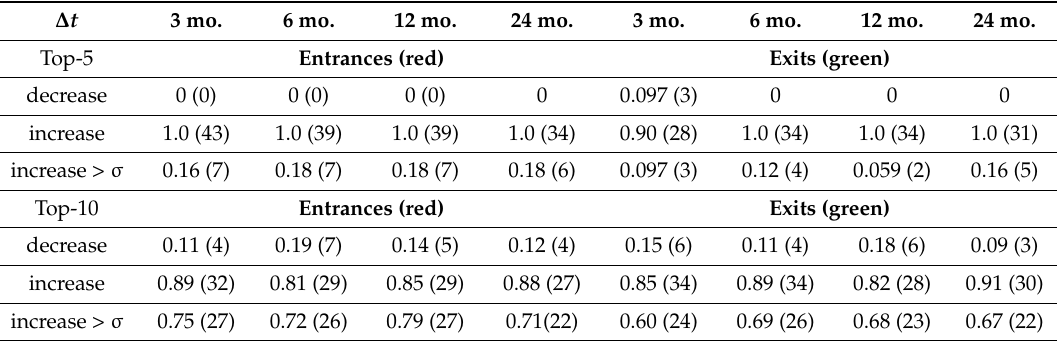
Table 3. Rates (and the counted numbers in the brackets) of the in/decrease of stock prices at (i.e., from the period of length ∆ t before to ∆ t after each entrance/exit) the entrances or the exits of pills, unifying the counts for W = 3, 4, 5, 6 for top-10, W = 7, 8, 9, 10 for top-5. The pair “stock ID: the time” in a red/green node in Figures 4–6 are counted uniquely (one time for each pair). σ indicates the standard deviation of the price of each stock for the period of length ∆ t before t . ∆ t 3 mo. 6 mo. 12 mo. 24 mo. 3 mo. 6